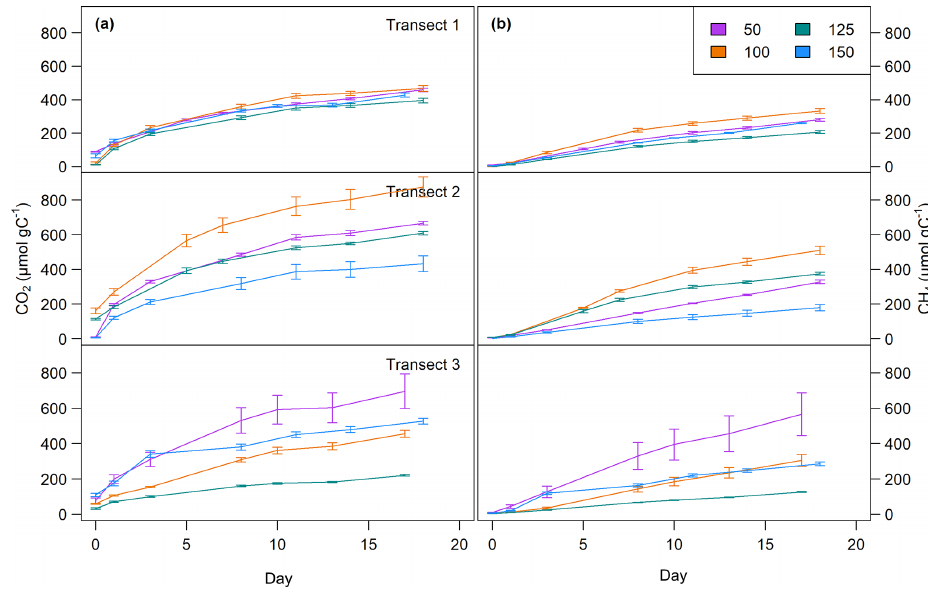
Figure 4. CO 2 (a) and CH 4 (b) production over time at all sites at 0–5cm sediment depth. Top: transect 1; middle: transect 2; bottom: transect 3. Lines are average values of triplicate measurements ( ±